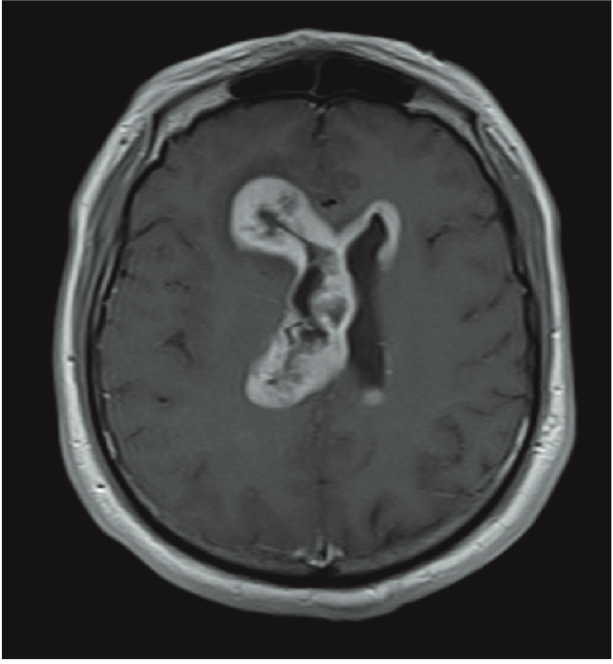
Fig. 5. FLAIR axial post-contrast view shows extensive subependymal infiltration of tumour.